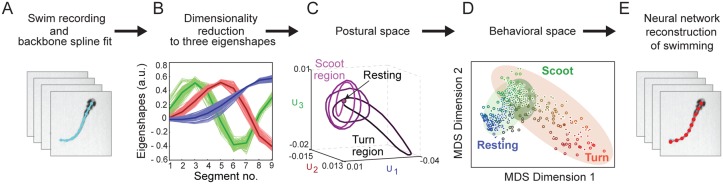
Workflow from swim observation to neuro-kinematic model.(A) Snapshots of a larval zebrafish free swimming movie in which the fish backbone is fitted to a 10-point spline. (B) A linear combination of three “eigenshapes” accurately reconstructs the backbone shapes of the zebrafish. (C) A swimming bout is represented as a trajectory in the “postural space” spanned by the three eigenshapes. (D) A “behavioral space” generated by multi-dimensional scaling reduces each cycle of a trajectory to a point, and clusters them by their similarity. (E) A 2-channel neuro-kinematic model is constructed based on the observed behavioral patterns and evaluated using the same work flow.